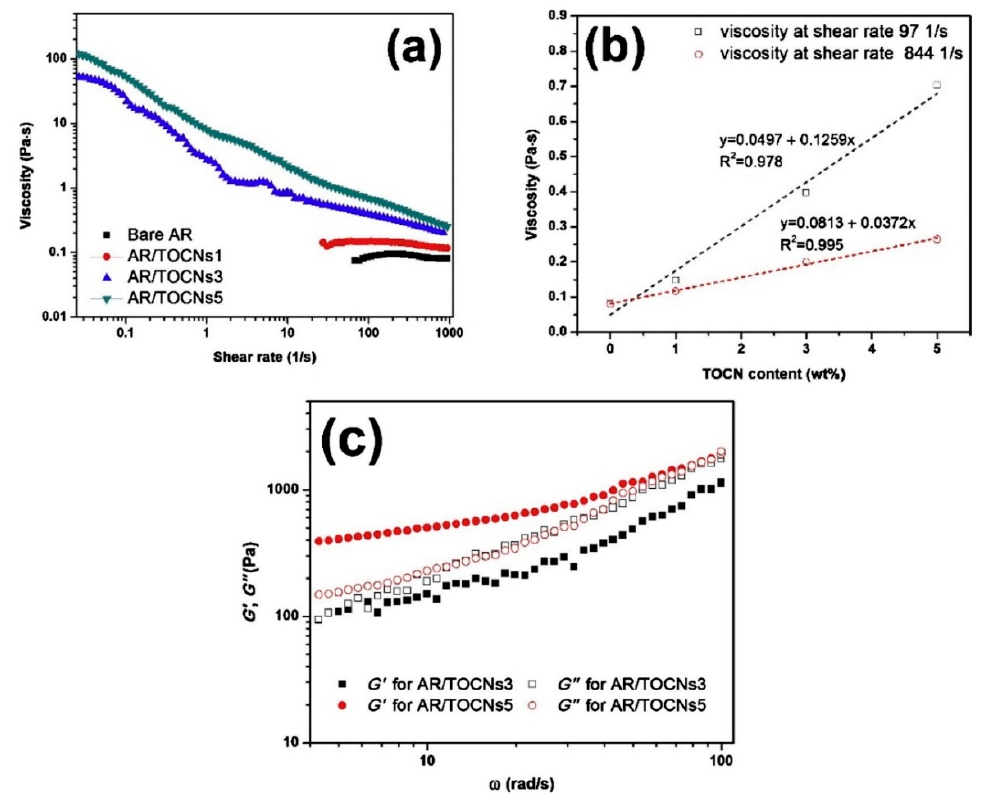
Figure 21. ( a ) Shear viscosity as a function of shear rate; ( b ) shear viscosity as a function of TOCN contents at two constant shear rates; ( c ) storage modulus G ′ and loss modulus G ′′ as functions of angular frequency ω [93].